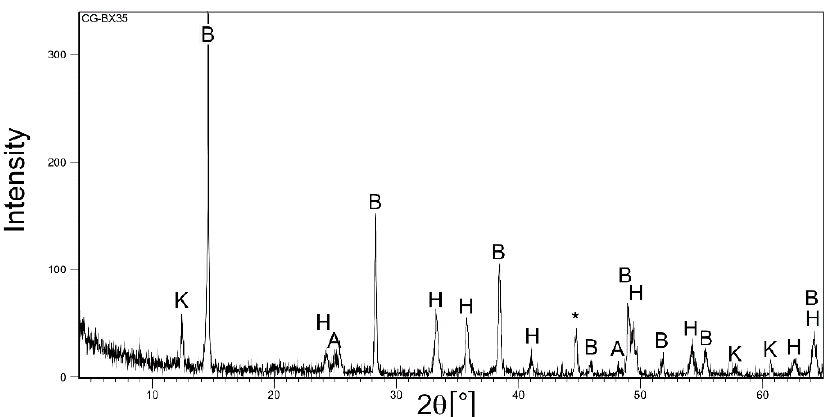
Figure 7. XRD patterns of typical analysed sample from Štitovo II deposit (B—böhmite, A—anatase, H—hematite, K—kaolinite, *—Al-sample holder) (REEBAUX project documentation, Tomaši´c